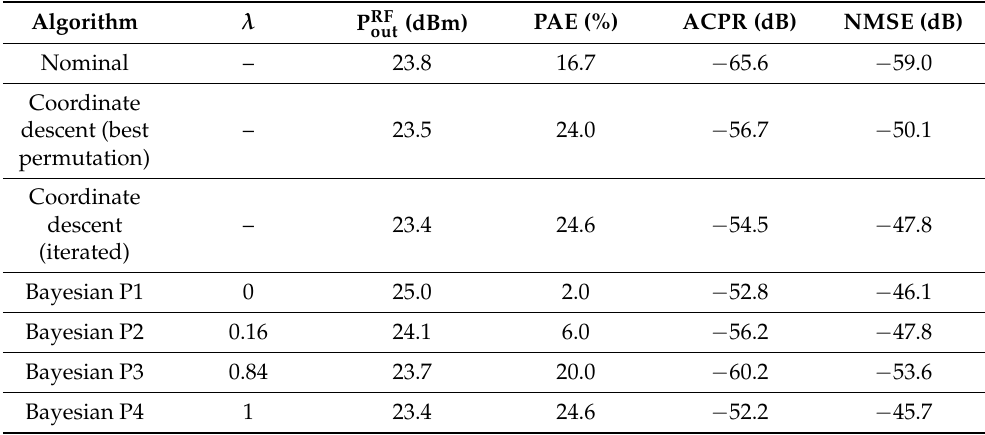
Figure 11. PA gain and AM/PM characteristics before (blue lines) and after linearization (red lines) with PA parameters at ( a ) nominal values, ( b ) after coordinate descent (iterated) optimization, and ( c ) after Bayesian optimization (P4). Table 6. Comparison of PA performances obtained by means of envelope simulation with modulated signals at the optimal points found running the coordinate descent or Bayesian optimizations on the PDF-based